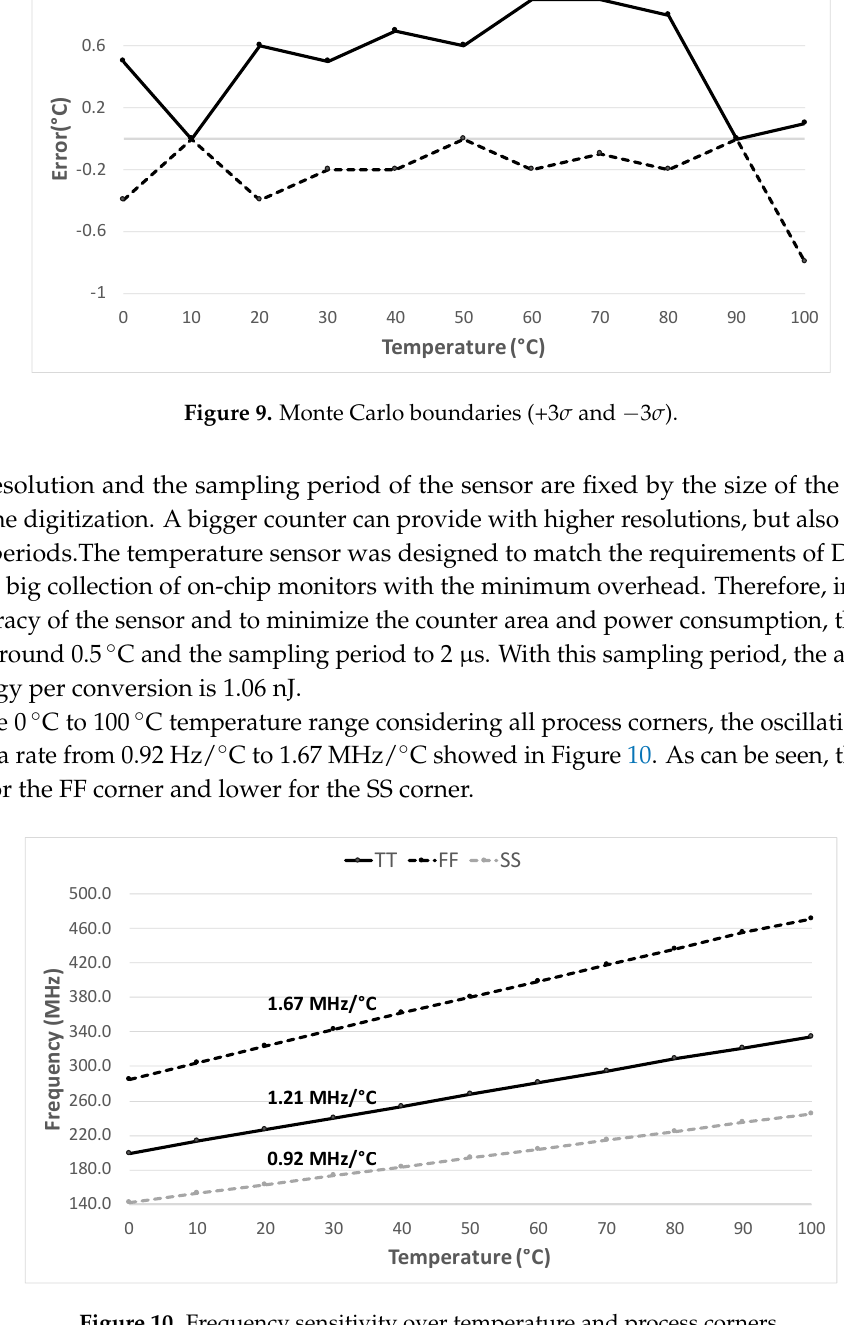
Figure 10. Frequency sensitivity over temperature and process